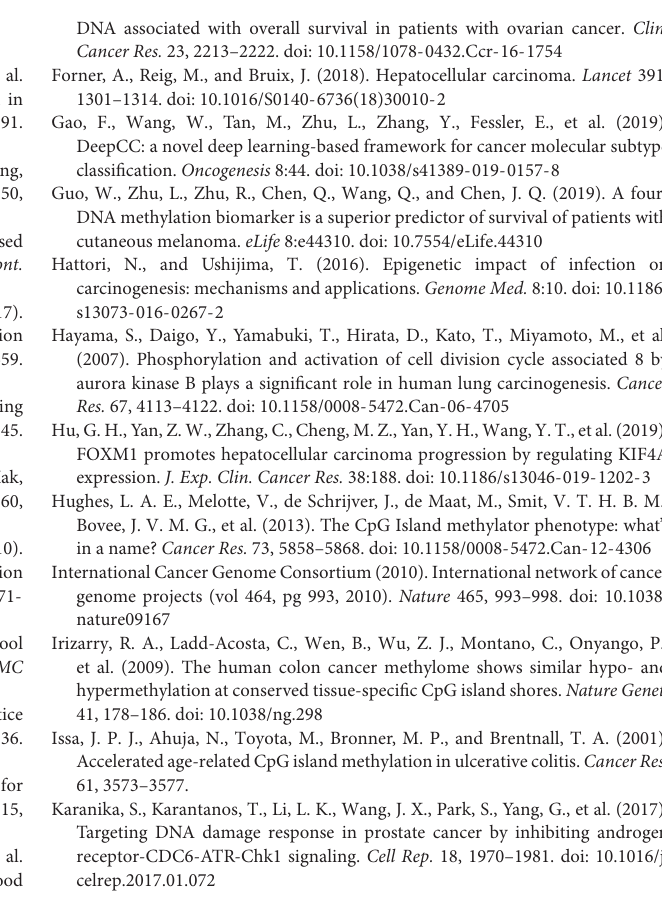
methylation markers at 10, 50, 300, 500, and 1000 simulated assessments. Right panel: the red dotted line indicates the diagnostic signature with five DNA methylation markers to have the highest balanced accuracy after 300 simulations. TABLE S1 | The result of the simulation. TABLE S2 | Characteristics of five methylation markers used in the diagnostic signature. TABLE S3 | Information regarding datasets used in this study. TABLE S4 | Clinical characteristics of HCC patients in the TCGA dataset. TABLE S5 | Characteristics of four methylation markers used in the prognostic signature. TABLE S6 | Results of KM and ROC analysis based on different regrouping